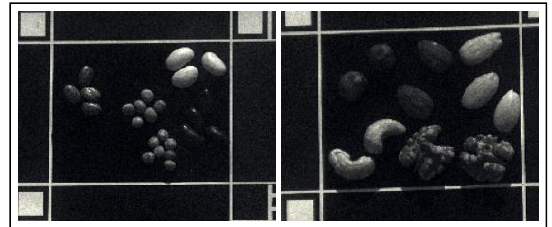
Figure 1. Exemplary image scenes of the Cubert dataset (band 1, mean wavelength 482.98 nm).